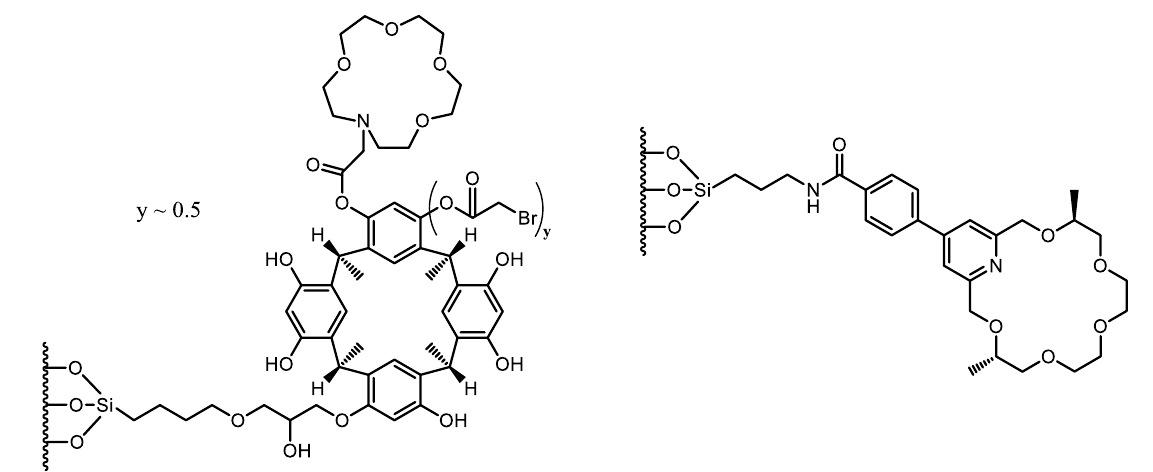
Figure 3. Structures of CSPs applied in Ref. [26] (left) and Ref. [27] (right).